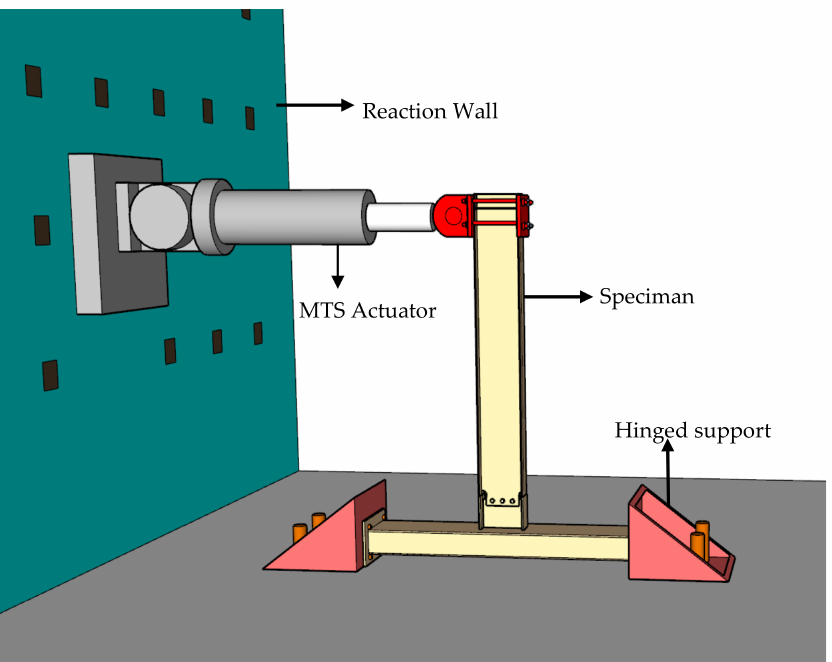
Figure 8. Test setup.